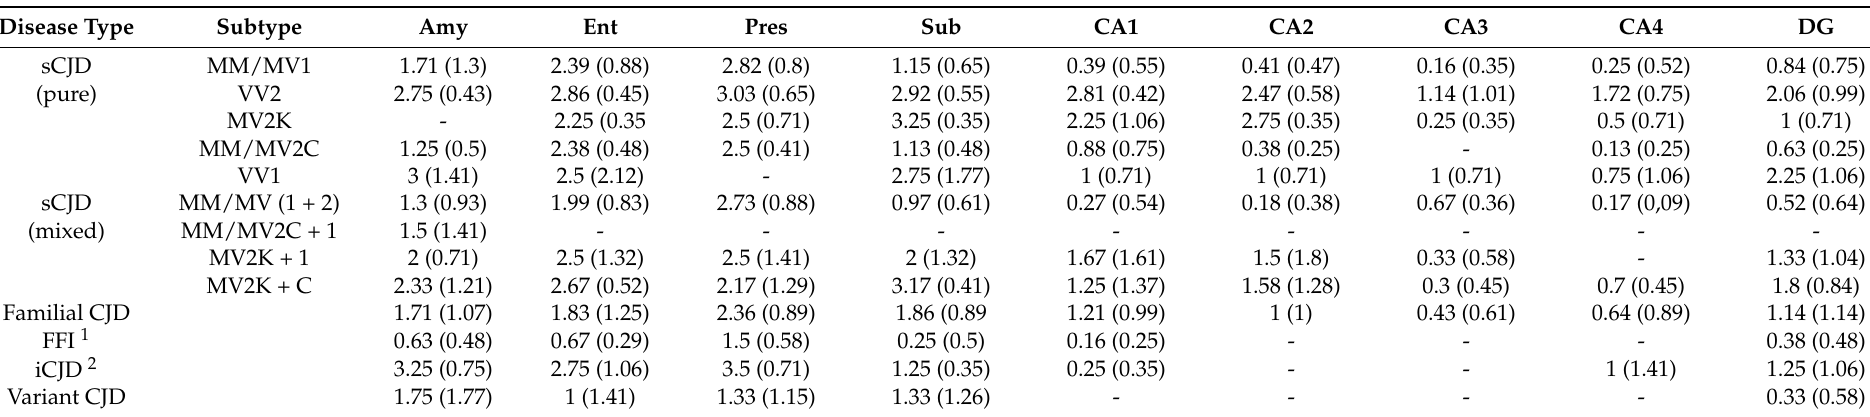
Table 2. Average involvement score (Ai, mean, [SD]) for all assessed structures of the medial temporal lobe in different types and subtypes of human prion diseases included in the patient